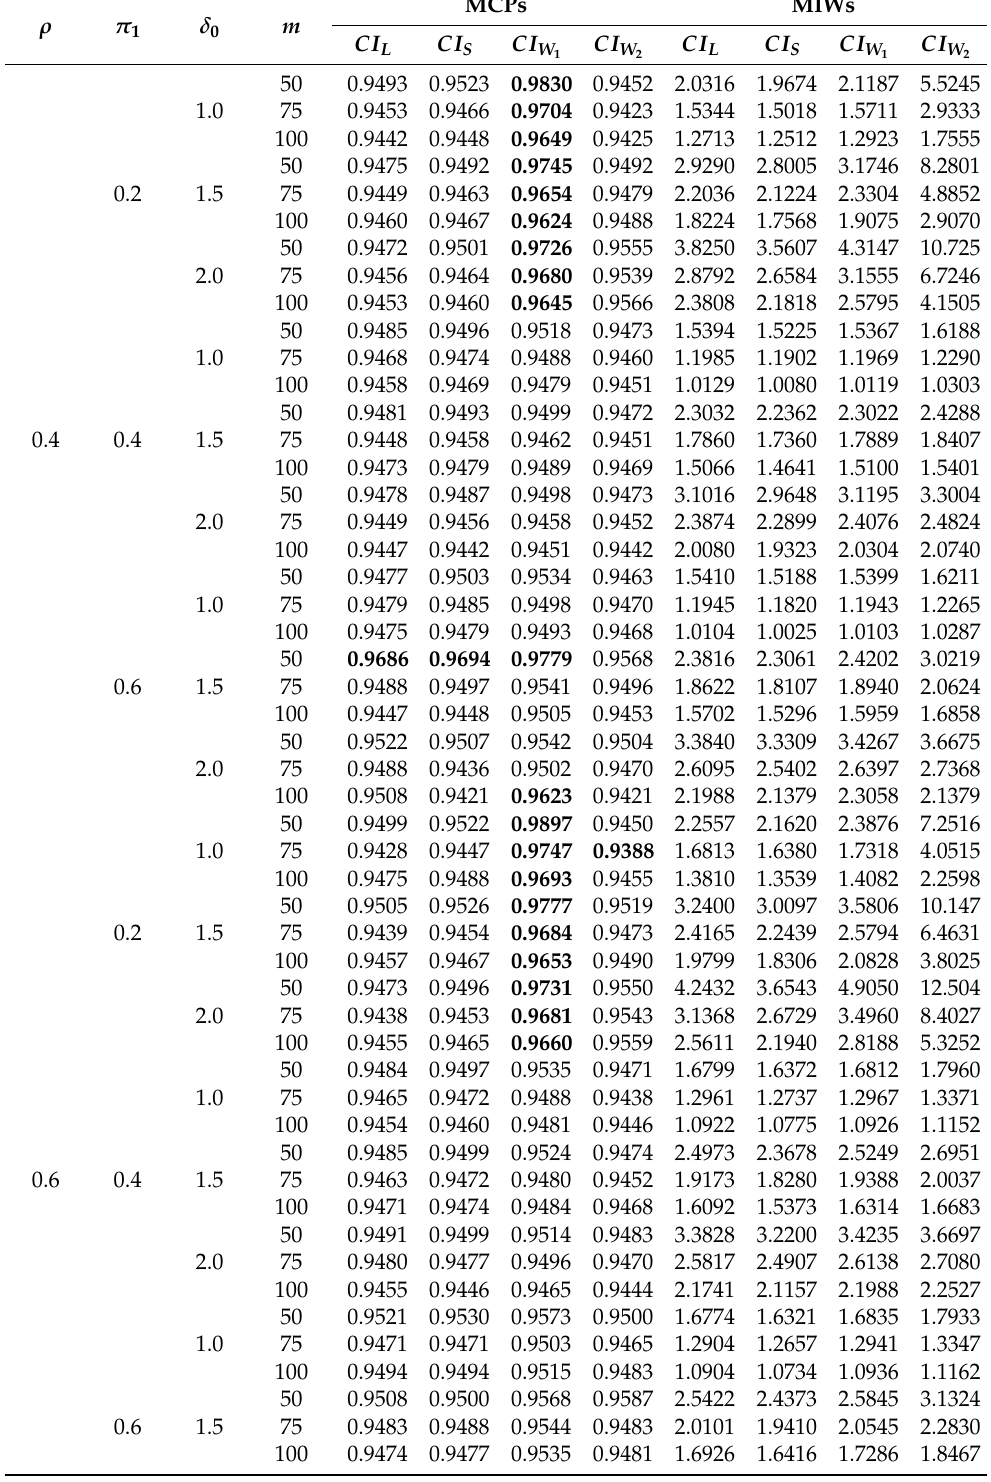
Table 4. MCPs and MIWs of CI